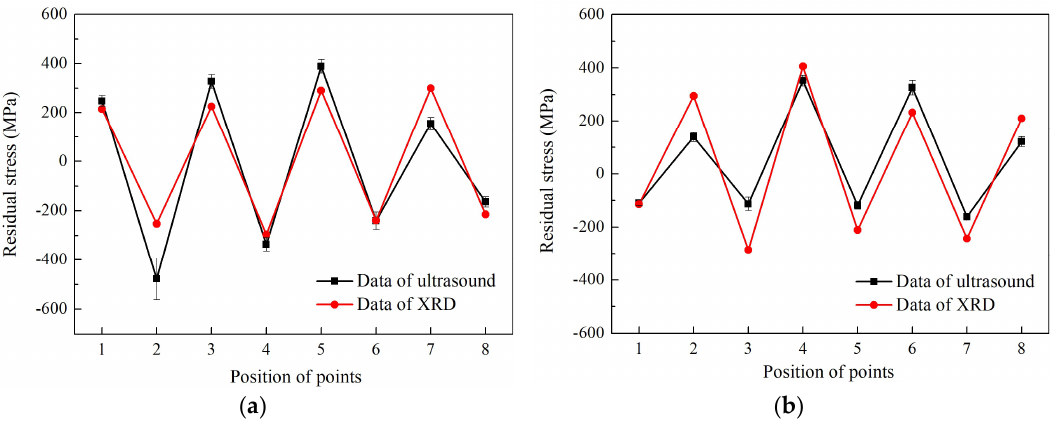
Figure 8. Comparison of stress results measured by ultrasound and XRD in Specimen 2#: ( a ) x -axial direction; and ( b ) y -axial direction.